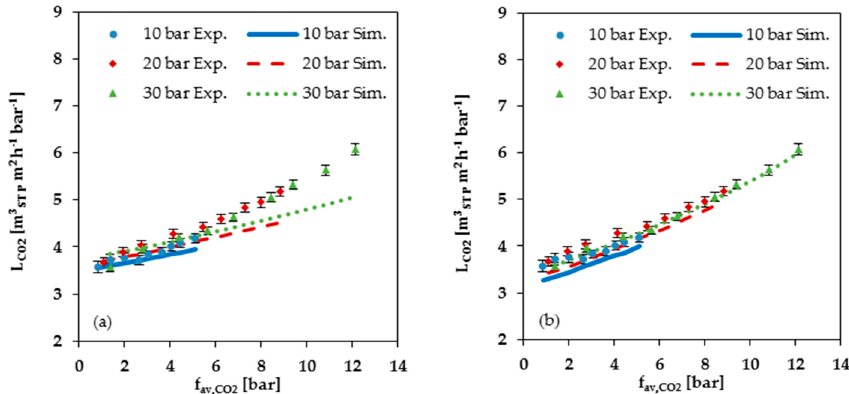
Figure 8. Comparison of measured data (Exp.) with simulated data (Sim.) for CO 2 permeance at 25 °C plotted against average CO 2 fugacity: ( a ) Simulation data based on FVM parameters determined from low pressure (up to 2 bar) single gas data; ( b ) Simulation data based on FVM parameters determined from high pressure (2 to 30 bar) single gas data.